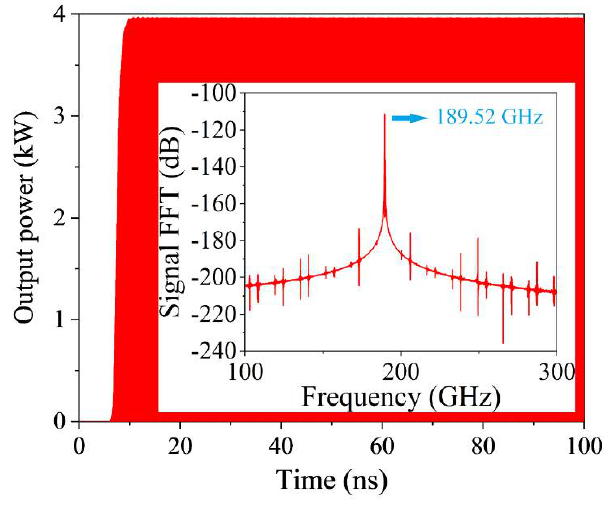
Figure 7. Output power and the corresponding frequency spectrum (inset).